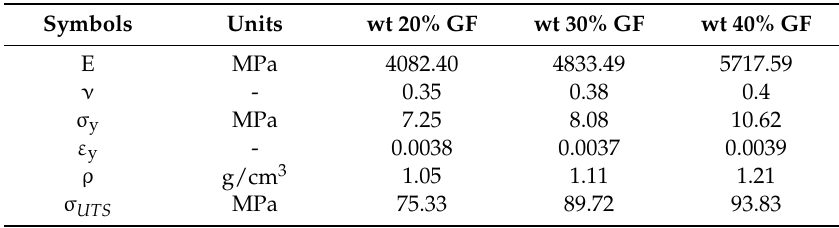
Figure 3. Results of the tensile test: ( a ) engineering strain–stress curve of experimental; ( b ) offset yield stress of GFRP. Table 1. Mechanical properties of GFRP.